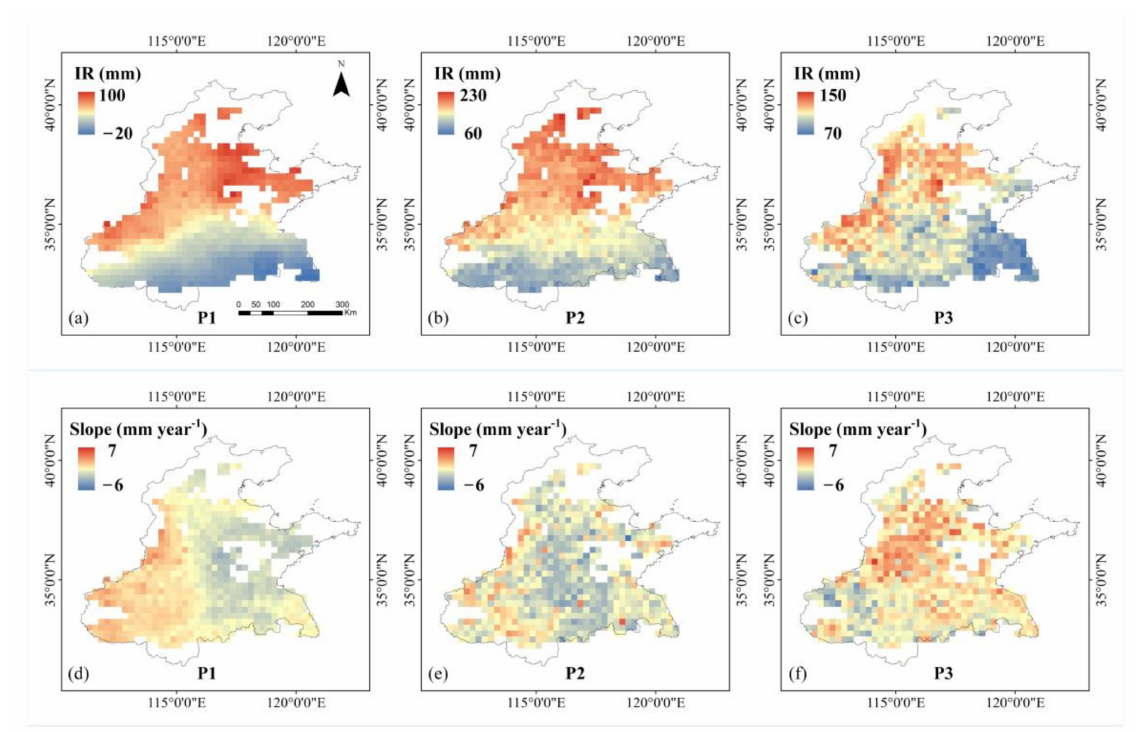
Figure 3. The average ( a – c ) and trends ( d – f ) distribution of the irrigation water requirements in P1 ( a , d ), P2 ( b , e ) and P3 ( c , f ) stages of winter wheat from 2000 to 2020.